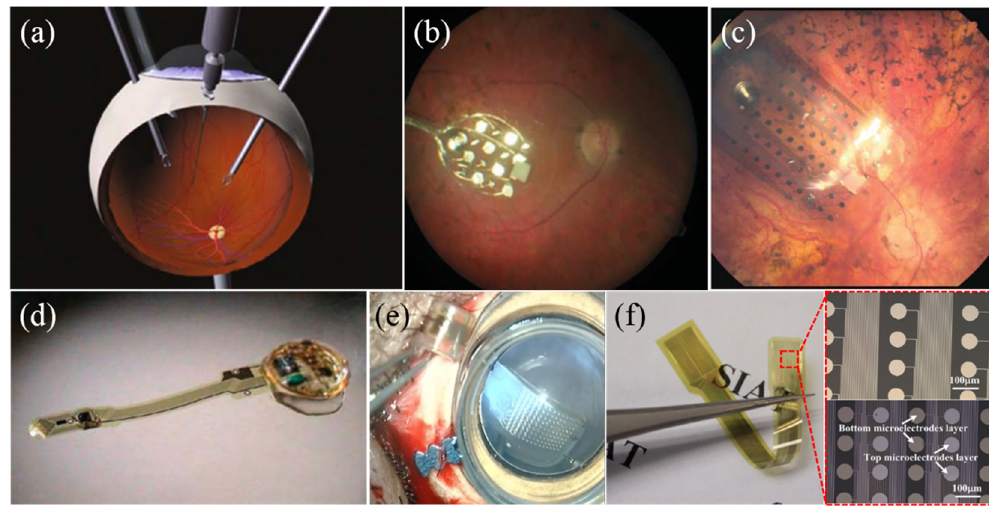
Figure 6. ( a ) The configuration of one of the very first patient tests [57]; ( b ) implanted 16-channel electrode array of Argus I [7]; ( c ) electrode array of Argus II implant containing 60 electrodes [66]; ( d ) an epiretinal stimulator with a thin-film polyimide cable of gold traces [59]; ( e ) 126-channel electrode implanted in the eyes of mini-pigs by our group; ( f ) 1025-channel electrode fabricated by our group [64,65]. Reproduced from the mentioned references with permission from the related journals.